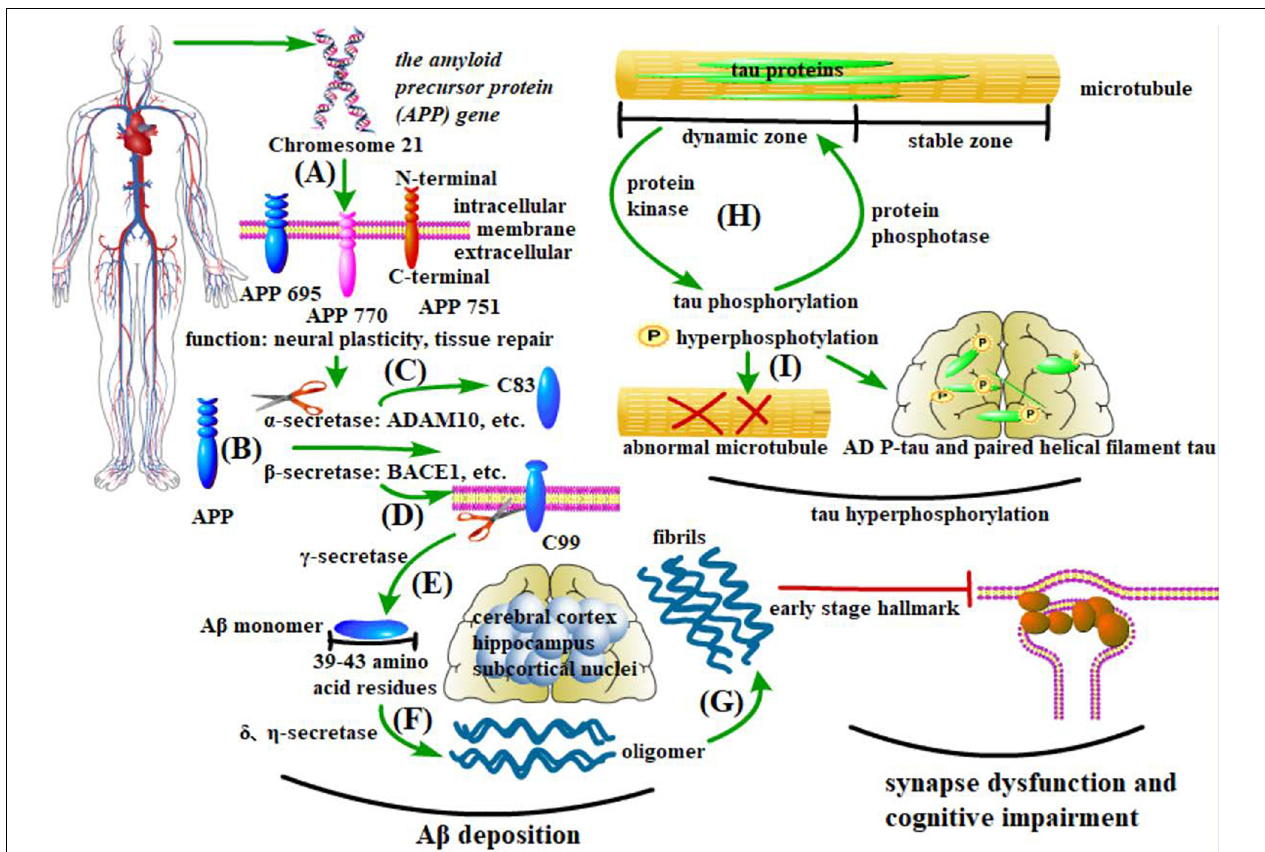
FIGURE 1 | Pathological changes in AD. (A–G) A β deposition and synapse dysfunction: the amyloid precursor protein ( APP ) gene generates at least three isomers of APP proteins in the brain. β -secretase cleaves APP into the C-terminal fragment C99, which is sequentially processed by γ -secretase to produce A β . In contrast, α -secretase cleaves APP into C83, which inhibits A β deposition. Under pathological conditions, the soluble A β monomer turns into oligomers and insoluble fibers, with the former being more pathogenic. Existing in the cerebral cortex, hippocampus, and some subcortical nuclei, these anomalously aggregated A β s cause synapse dysfunction, thus leading to cognitive impairment. (H,I) Tau protein phosphorylation: microtubules have both dynamic and stable zones, and tau mostly exists in the former. As major microtubule-associated proteins in nerve cells, the phosphorylation and dephosphorylation of tau proteins are controlled by protein kinases and protein phosphatases (PP), respectively. Abnormality of these processes will cause an aberrant structure of microtubules. In AD brains, two aberrant forms of tau proteins (AD P-tau and paired helical filament tau) are the main components of